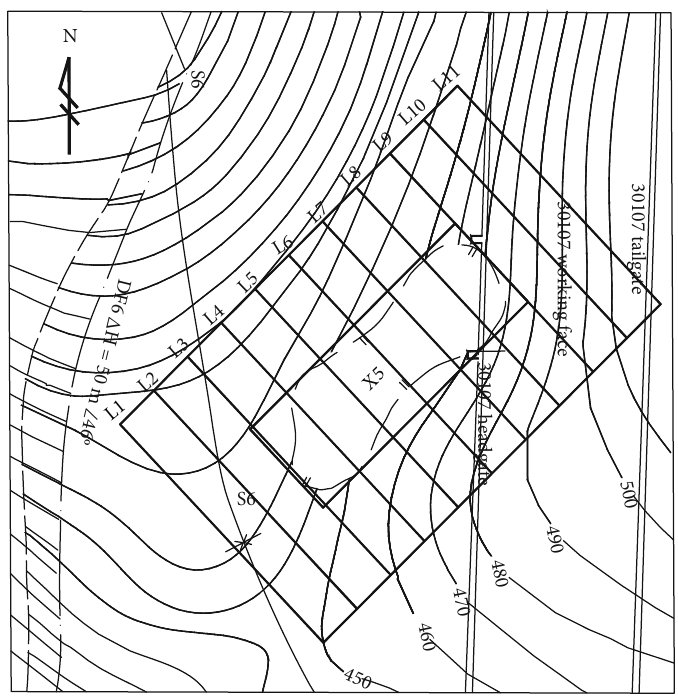
Figure 6: Layout of CSAMT survey lines in the X5